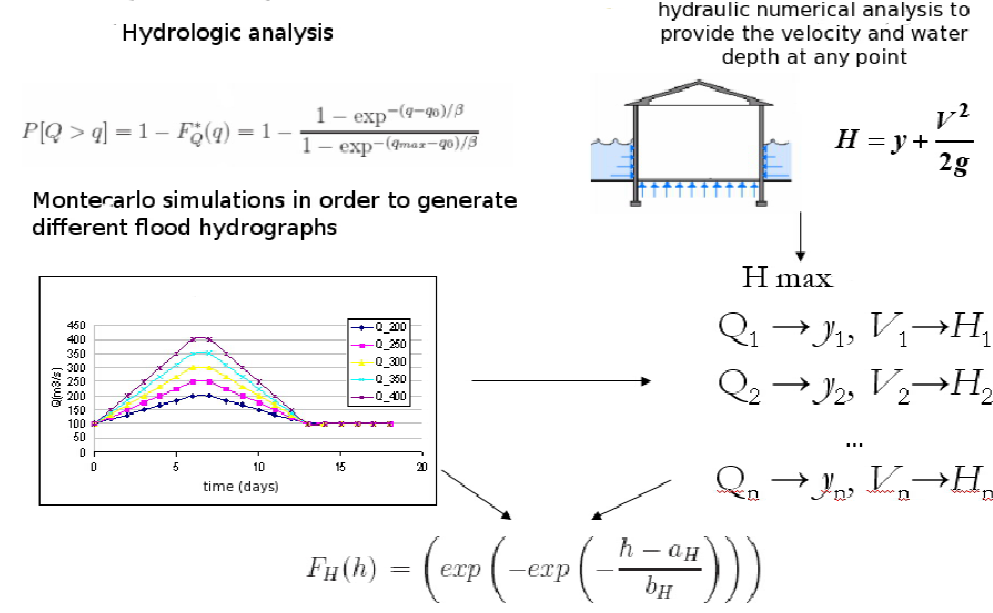
Fig. 4. Flowchart of the procedure for the distribution of the critical water elevation H Fig. 4. Example of data required for river